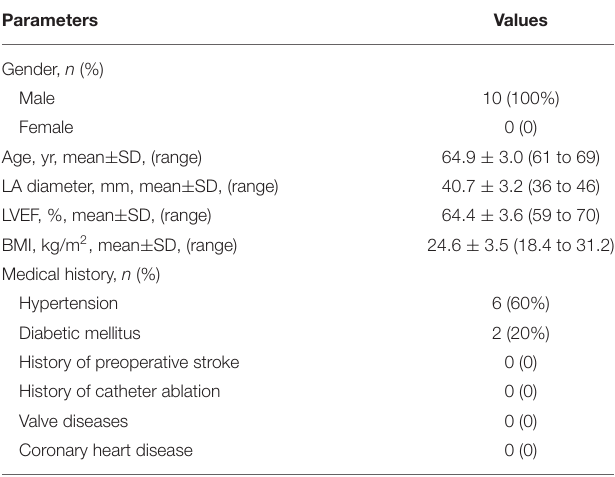
TABLE 2 | Baseline characteristics of